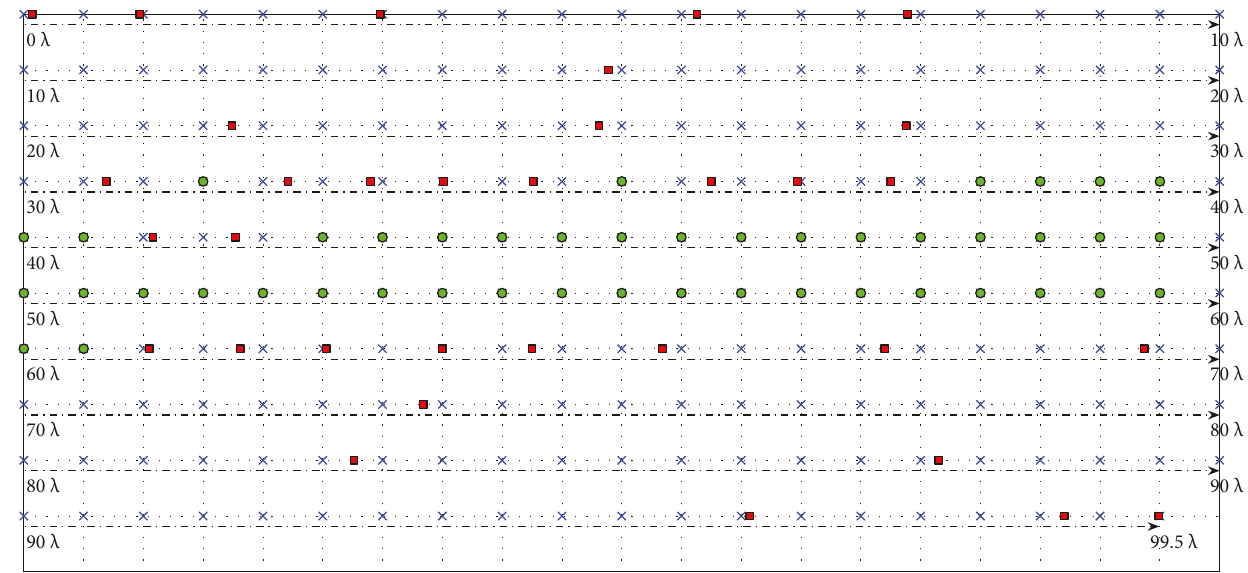
Figure 6: The element locations of the sparse linear array obtained by the IFT-DE based on an asymmetrical TLA with a fi lling factor of 39%. Table 1: Comparative synthesizing results by using the IFT-DE and some published tools. Filling factor of the TLA originally PSLL The structure of the SLA obtained by the IFT (%)